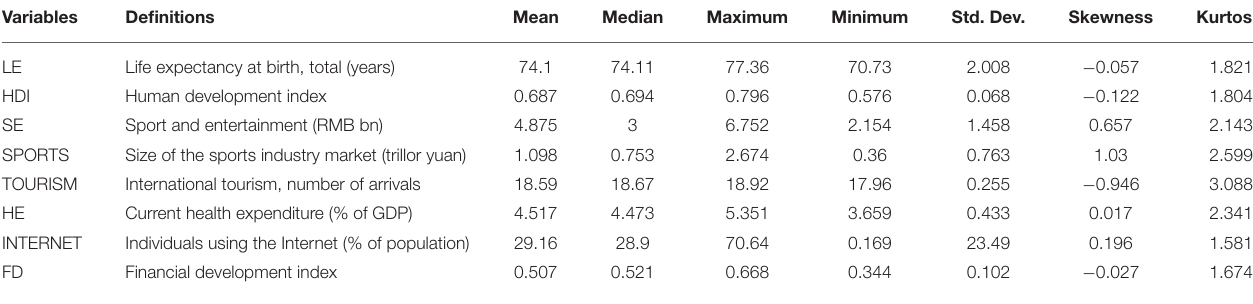
TABLE 1 | Variables definition and data